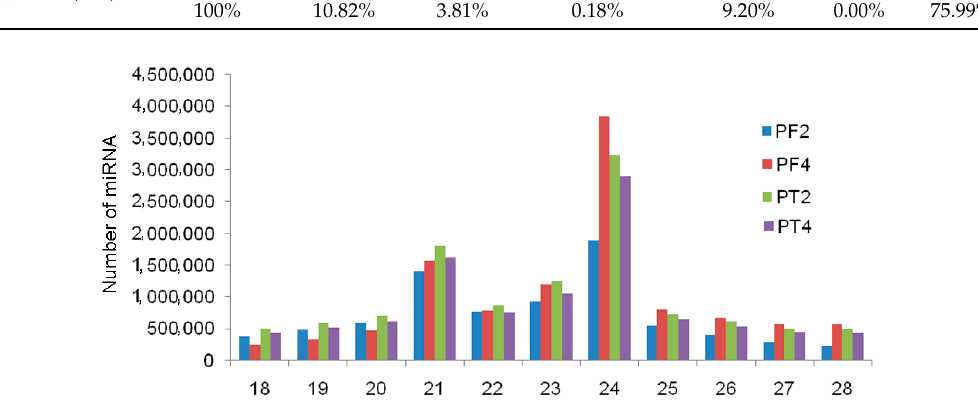
Figure 3. Length distribution of four Paulownia small RNAs PF2: diploid P. fortunei ; PF4: tetraploid